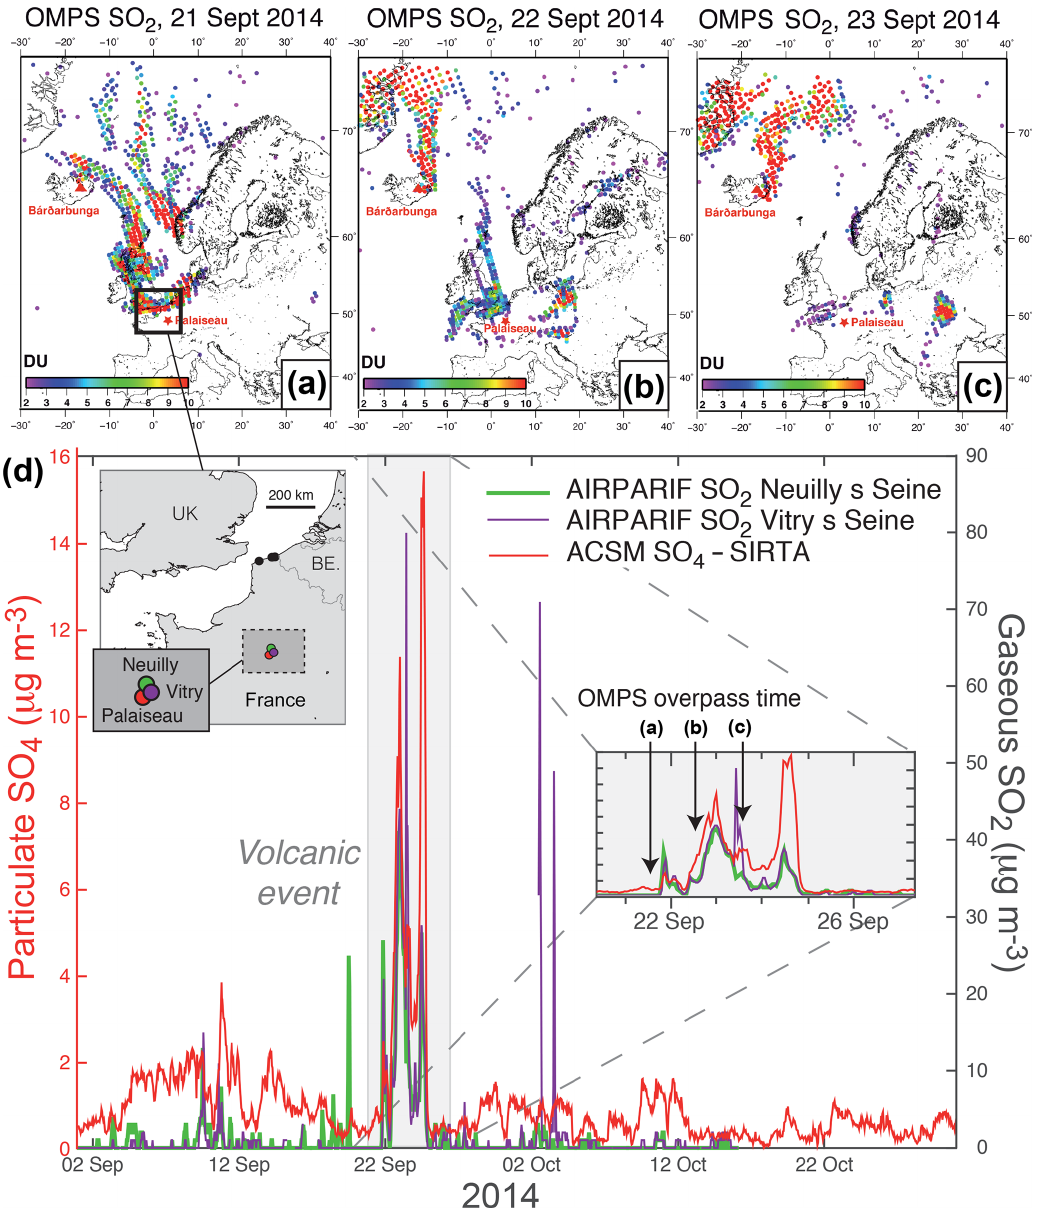
Figure 2. (a, b, c) OMPS L2 PBL observations (13:30 local time at the Equator) showing volcanic SO 2 from the Holuhraun eruption transported over northern France in late September 2014. (d) Hourly time series covering September–October 2014 of ground-level mass concentrations of (red) particulate SO 4 from ACSM at SIRTA and (green and purple) gaseous SO 2 from the regional neighbouring stations of Vitry-sur-Seine and Neuilly-sur-Seine belonging to the Airparif air quality monitoring network (station location indicated on the map). In the inset is a zoom on the period 19–26 September 2014, when the largest episode of volcanogenic air pollution in France took place.